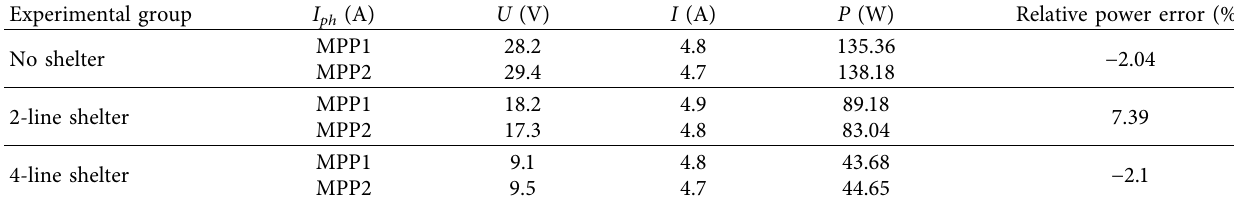
Table 4: Maximum power point computation.